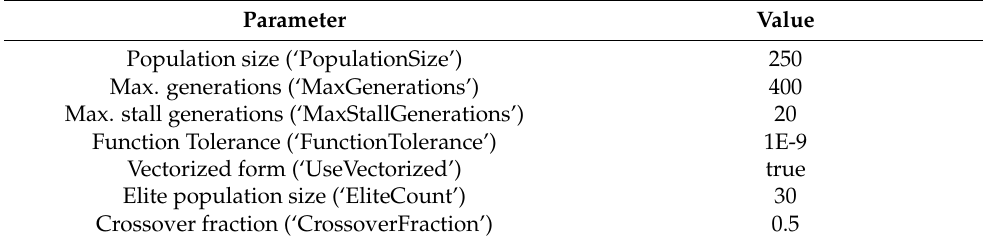
Table 3. ga solver